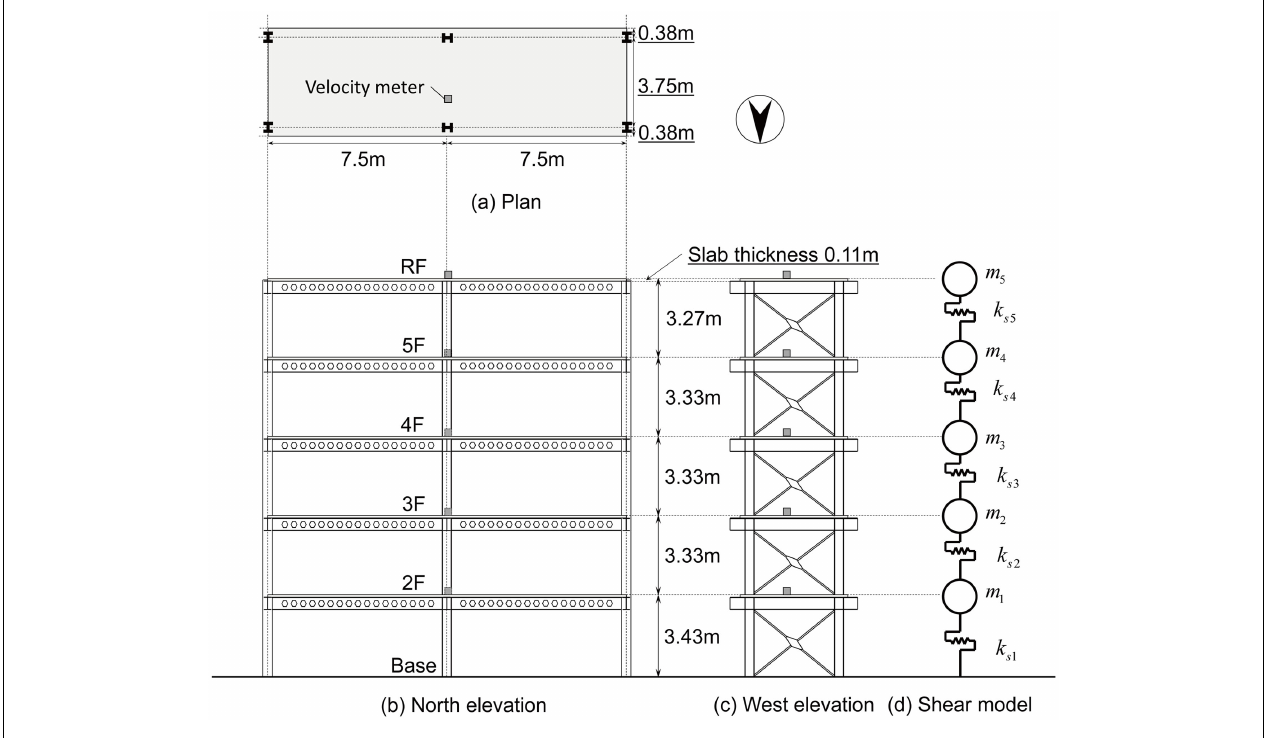
FIGURE 4 | Frame dimension and its shear building model .